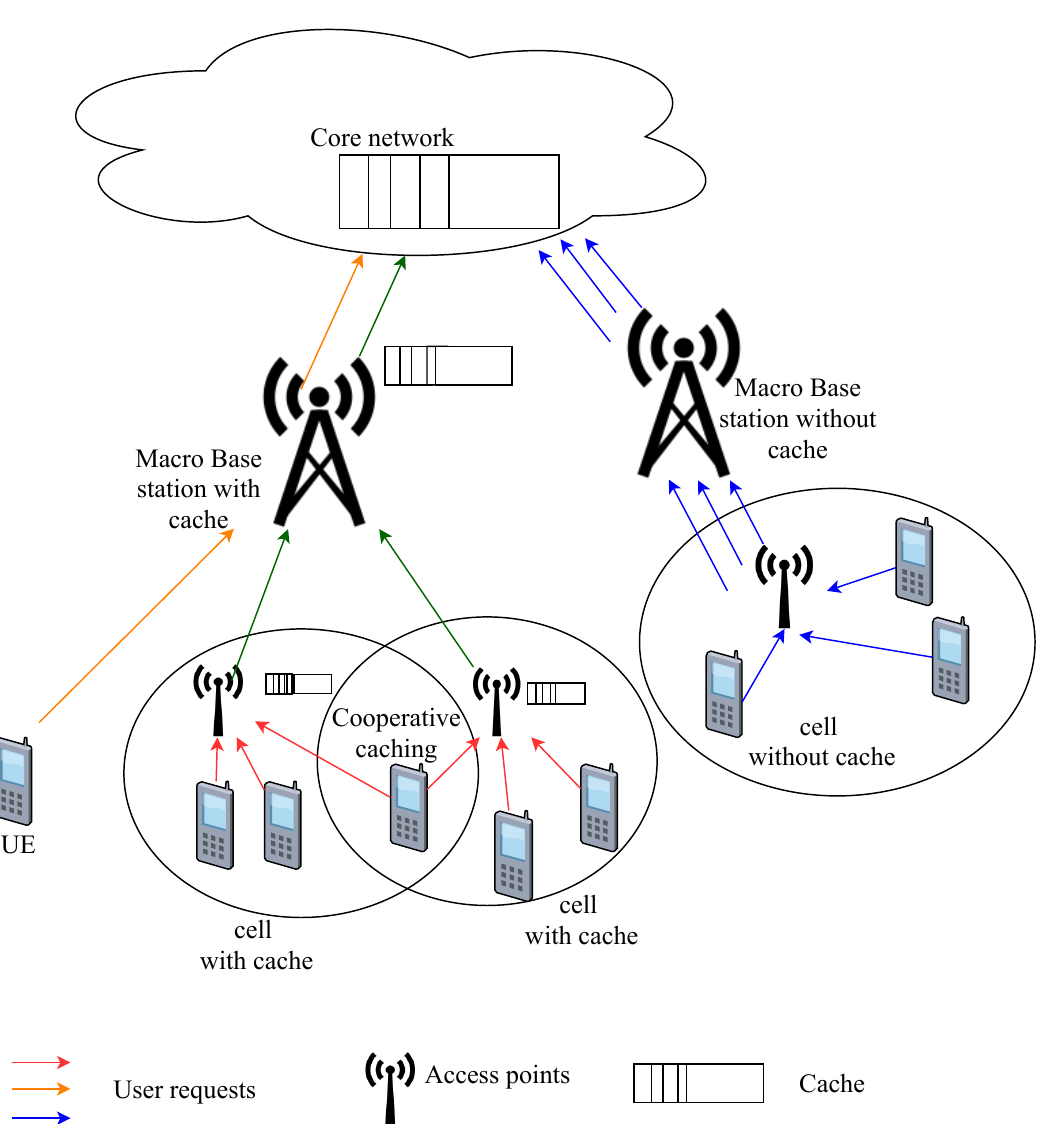
Figure 8. Effect of with and without caching on the data congestion in a mobile cellular wireless